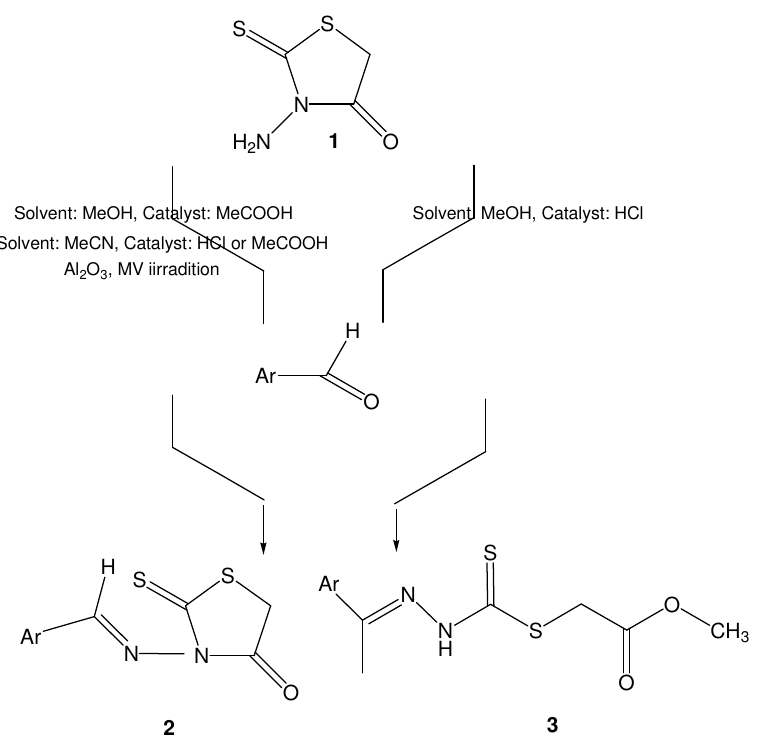
Scheme 1. Reaction of N -aminorhodanine with aromatic aldehydes under different